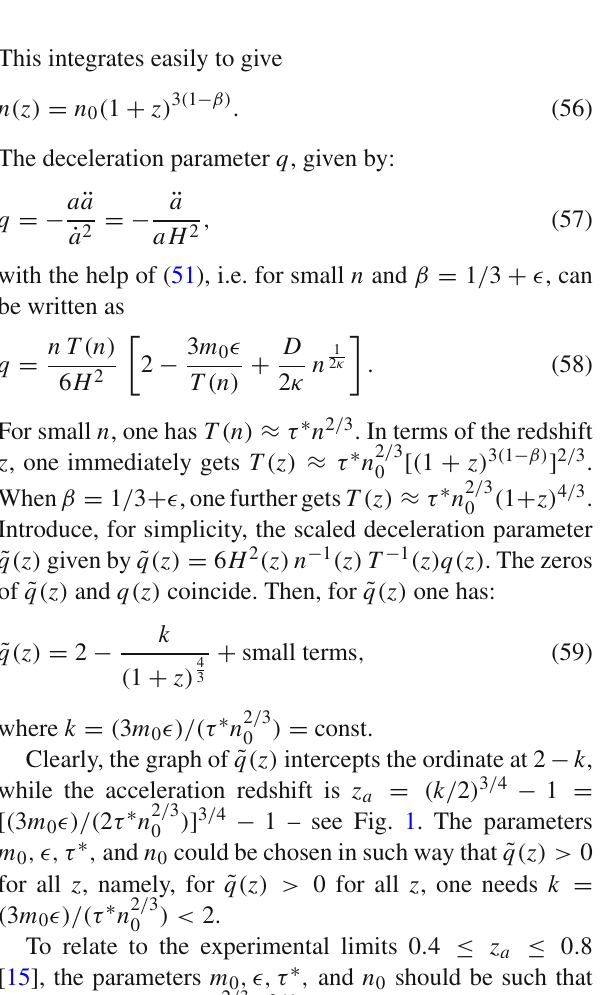
Fig. 1 Thescaleddecelerationparameter ˜ q = ( 6 H 2 )/( nT ) q (plotted with k = 4 which yields acceleration redshift z a = 0 .